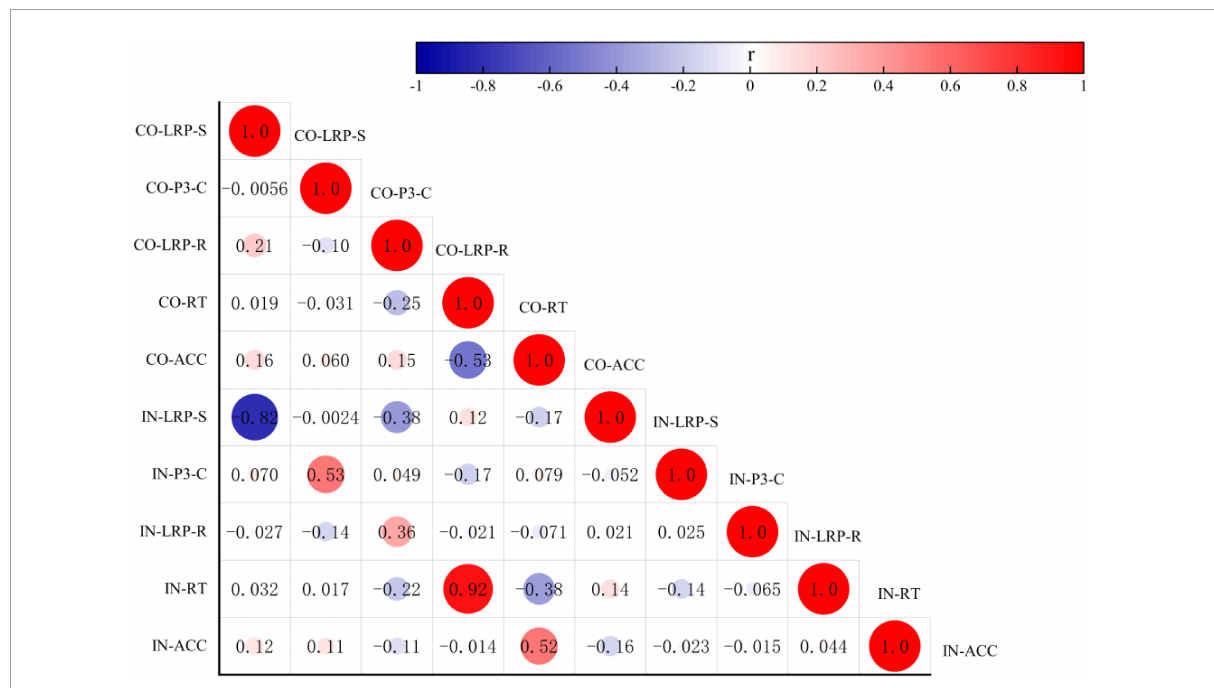
FIGURE5 Analysis of correlation among the behavioral data RT, ACC, and the amplitude of the ERP components LRP-S, LRP-R, and P300-C under congruent and incongruent conditions. CO, congruent condition; IN, incongruent condition.